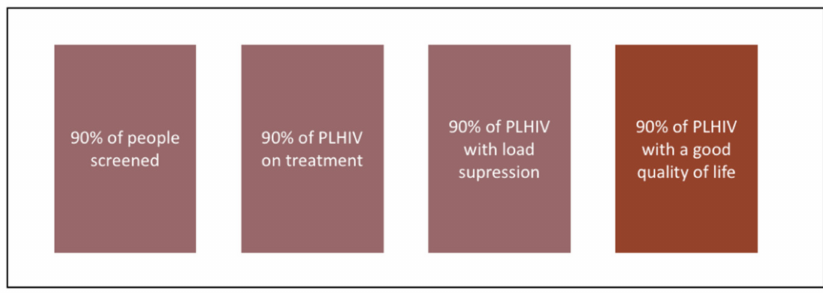
Figure 1. UNAIDS 90-90-90 targets and the 4th target added by Lazarus et al.